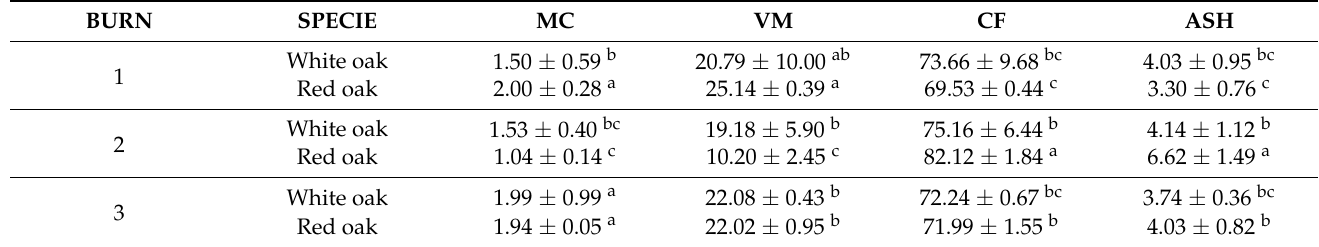
Table 9. Proximate analysis of charcoal produced in Argentine half-orange